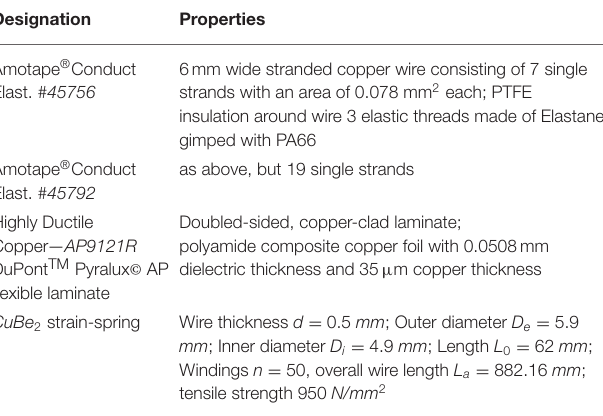
TABLE 2 | Materials used for stretchable areas. Amotape ® #45756 and Amotape ® #45792 provide the stretchability of the stranded wire by three elastic Elastane